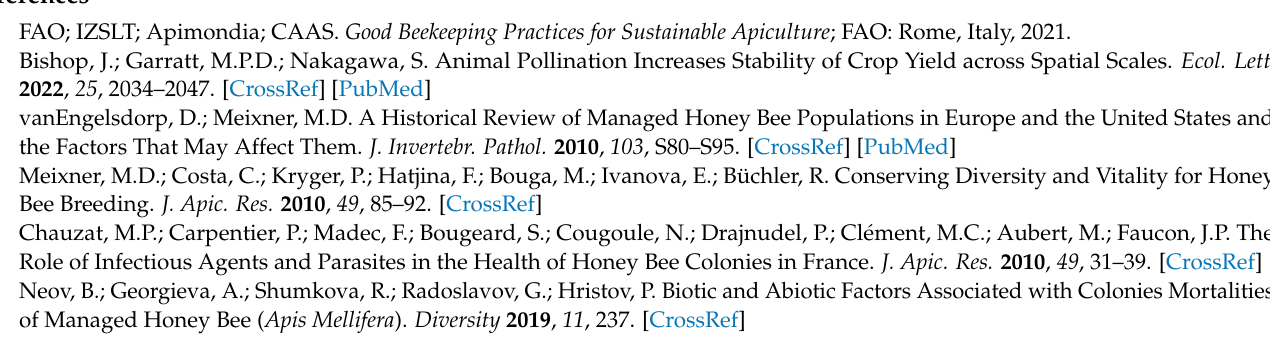
Table S3: Climatic conditions recorded per in mainland apiaries; Table S4: Colony losses and queen replacement per